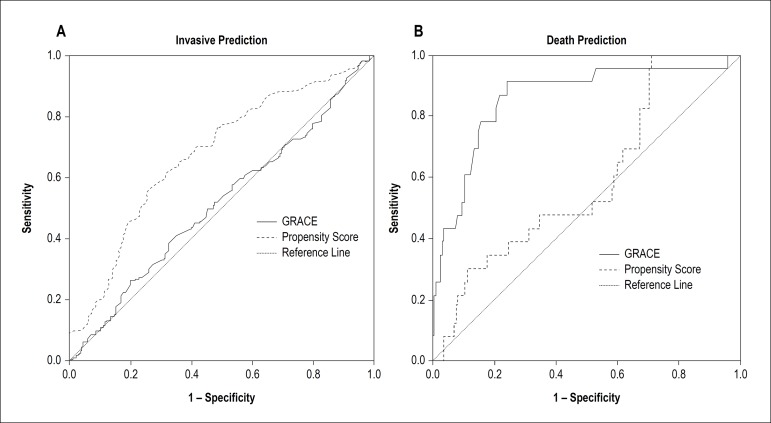
According to the area under the curve, GRACE Score does not predict an
invasive strategy, as opposed to the propensity score (Panel A, p <
0.001 for curve comparison). Conversely, GRACE Score is better than the
propensity Score for the prediction of mortality (Panel B, p <
0.001).